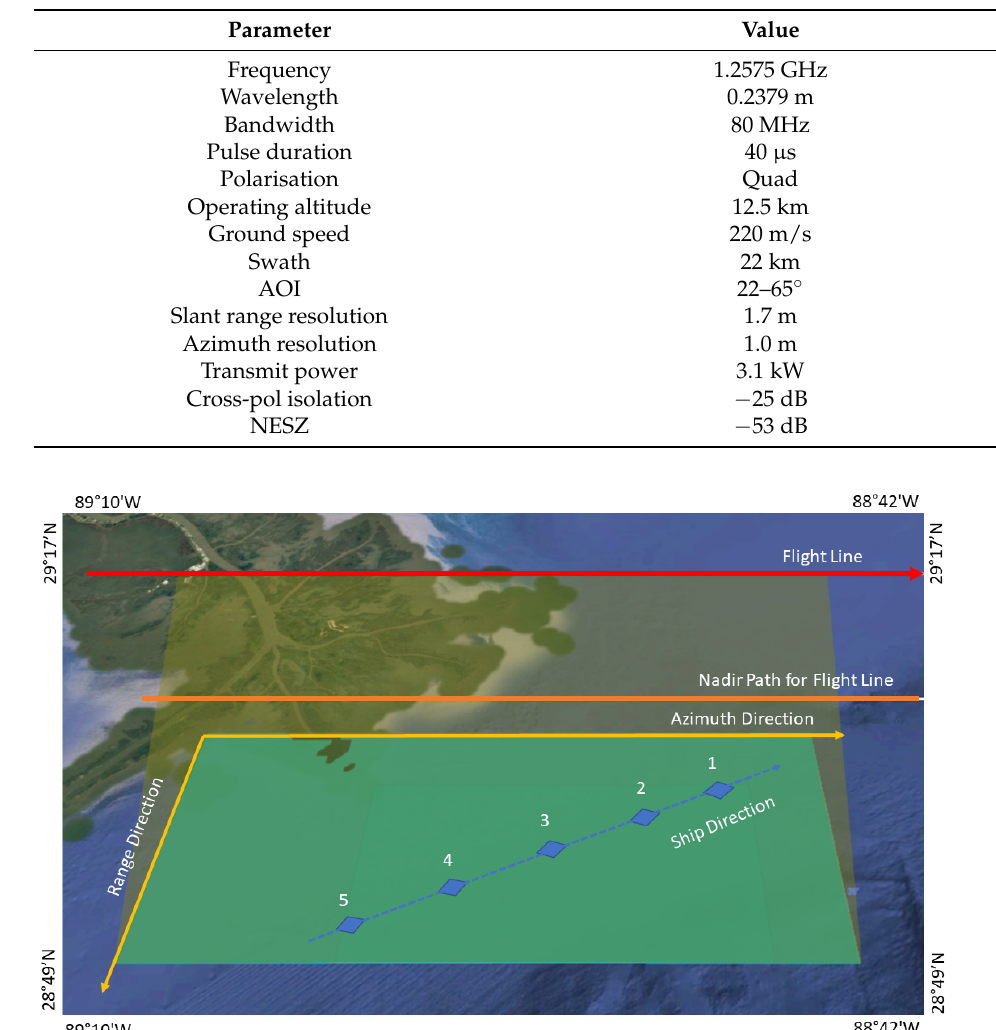
Figure 2. UAVSAR acquisition geometry. The flight line is depicted in red, while the observed area is shown as a light green patch. The ship location in the five SAR scenes is highlighted by the blue boxes, while its motion is depicted with the dashed blue arrow. The blue boxes are labeled from “1” to “5” that correspond to SAR acquisition at the lowest and highest AOI,